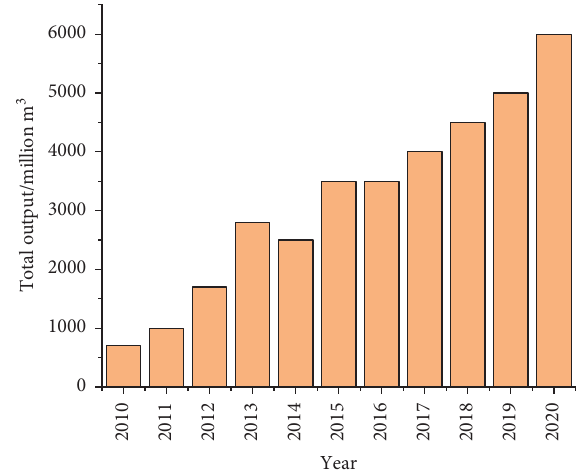
Figure 1: The annual total output of foamed concrete from 2010 to